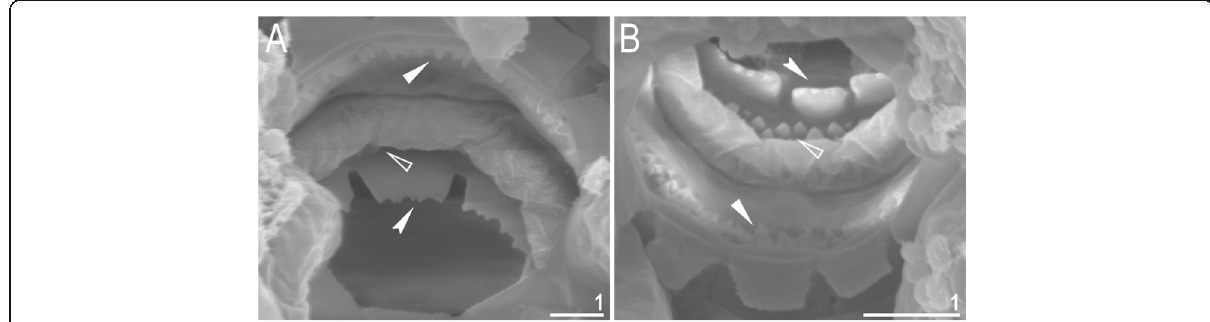
Fig. 17 Macrobiotus pseudopallarii sp. nov. from Montenegro (ME.007) – the oral cavity armature seen with SEM: a – b – the oral cavity armature of a single specimen seen with SEM from different angles showing dorsal and ventral portion, respectively. Filled flat arrowheads indicate the first band of teeth, empty flat arrowheads indicate the second band of teeth, and filled indented arrowheads indicate the third band of teeth. Scale bars in μ